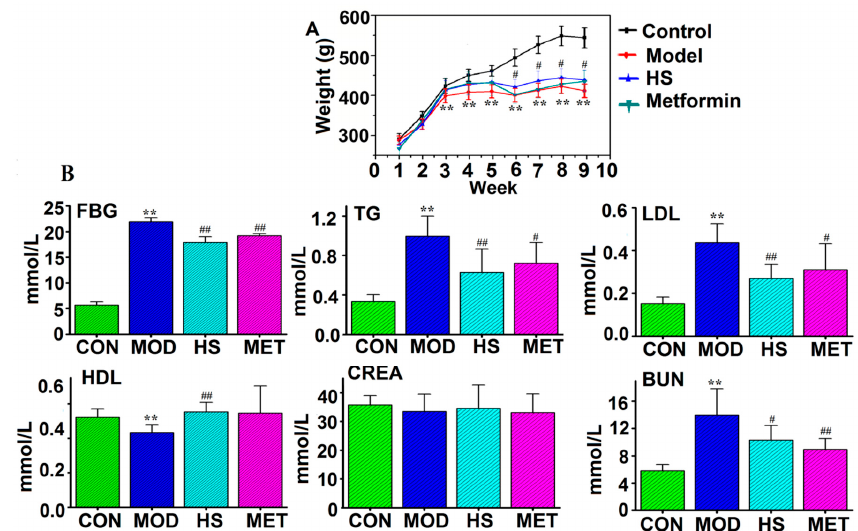
Figure 2. ( A ) The changes of the body weight at different time points in four groups; ( B ) The biochemical parameters used to evaluate the efficacy of the drug pair (HS) of Astragalus Radix (HQ) and Dioscoreae Rhizoma (SY) in the treatment of type 2 diabetes mellitus (T2DM). Error bars represent the mean ± SD (Student’s t-test: compared with the control group, * p < 0.05, ** p < 0.01; compared with the model group # p < 0.05, ## p < 0.01.